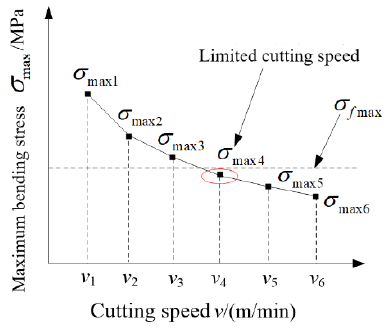
Figure 20. Determination of limit cutting speed.